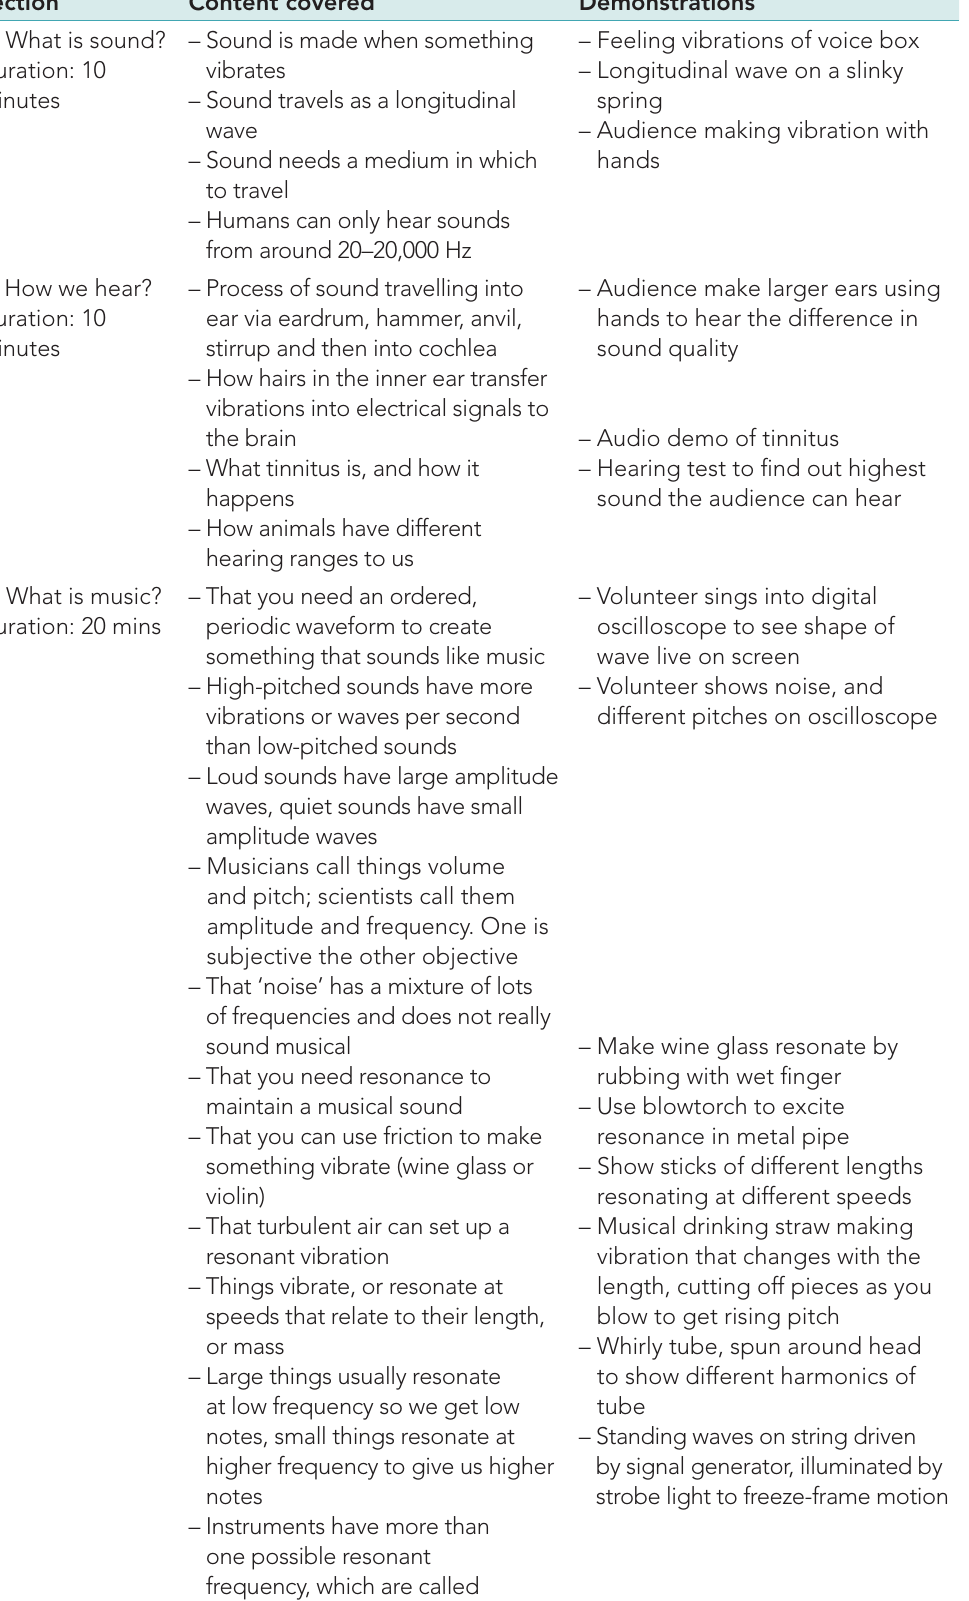
Table 1: summary of show content for Music to Your Ears section content